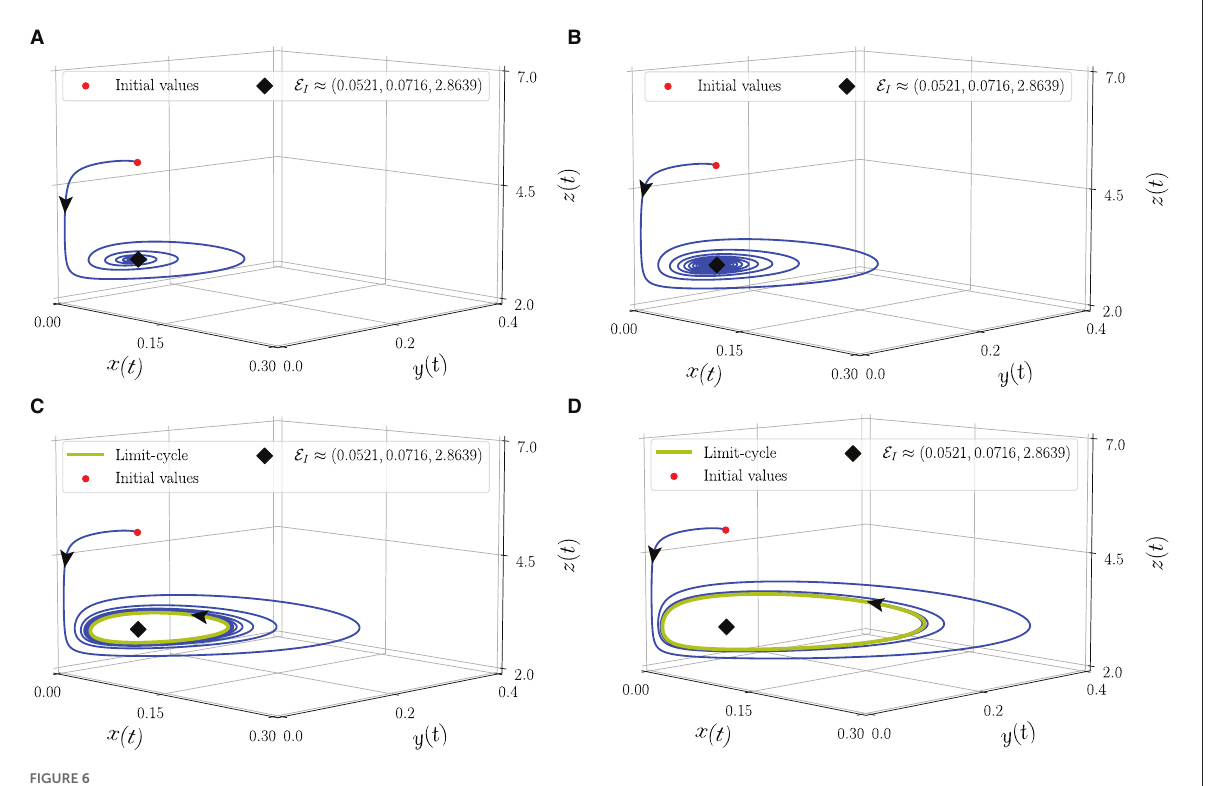
FIGURE6 Phase portrait of the model (Equation 3) around interior point E I using parameter values from Equation (26). (A) α = 0.81, (B) α = 0.84, (C) α = 0.87, and (D) α = 0.9.